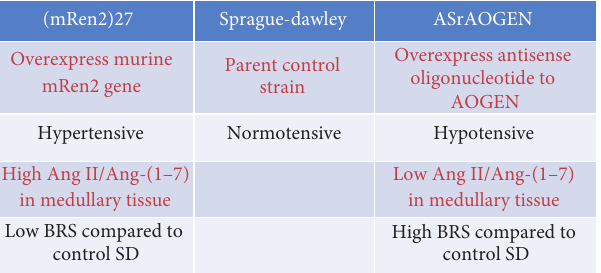
F2:Ma�orcharacteristicsof(mRen2)27,Sprague-Dawley(SD),andASrAOGENratstrainswithrespecttohemodynamicandbarore�ex function. AOGEN: angiotensinogen, BRS: barore�ex sensitivity, RAS: renin-angiotensin